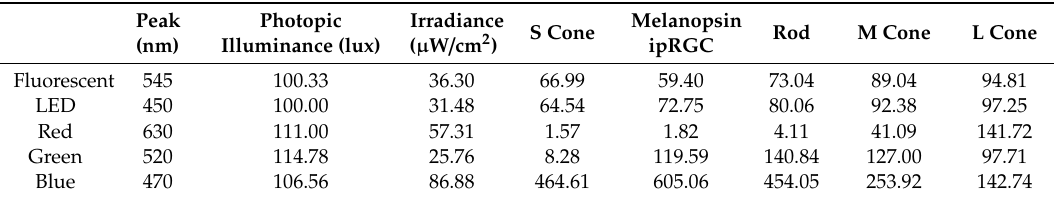
Table 1. Spectral characteristics, irradiance, and e ff ective illuminance for human photopigments for each of the light sources at ~100